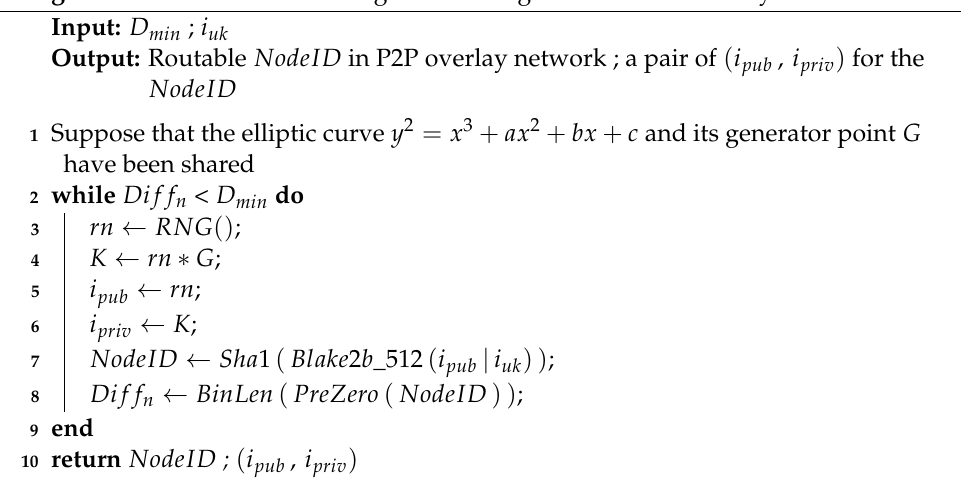
Algorithm 1: Routable NodeID generation algorithm in P2P overlay